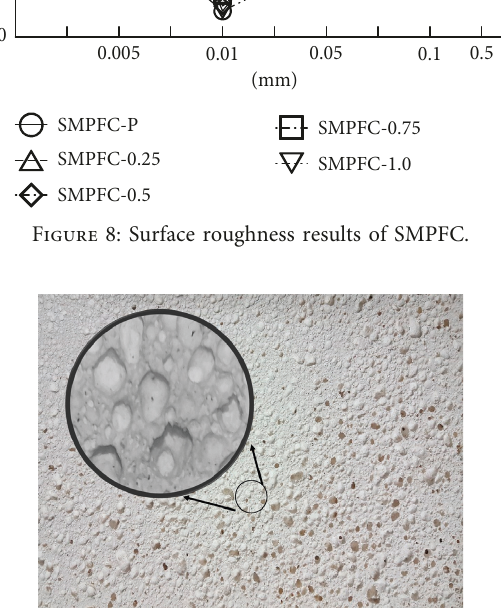
Figure 9: Surface of SMPFC.